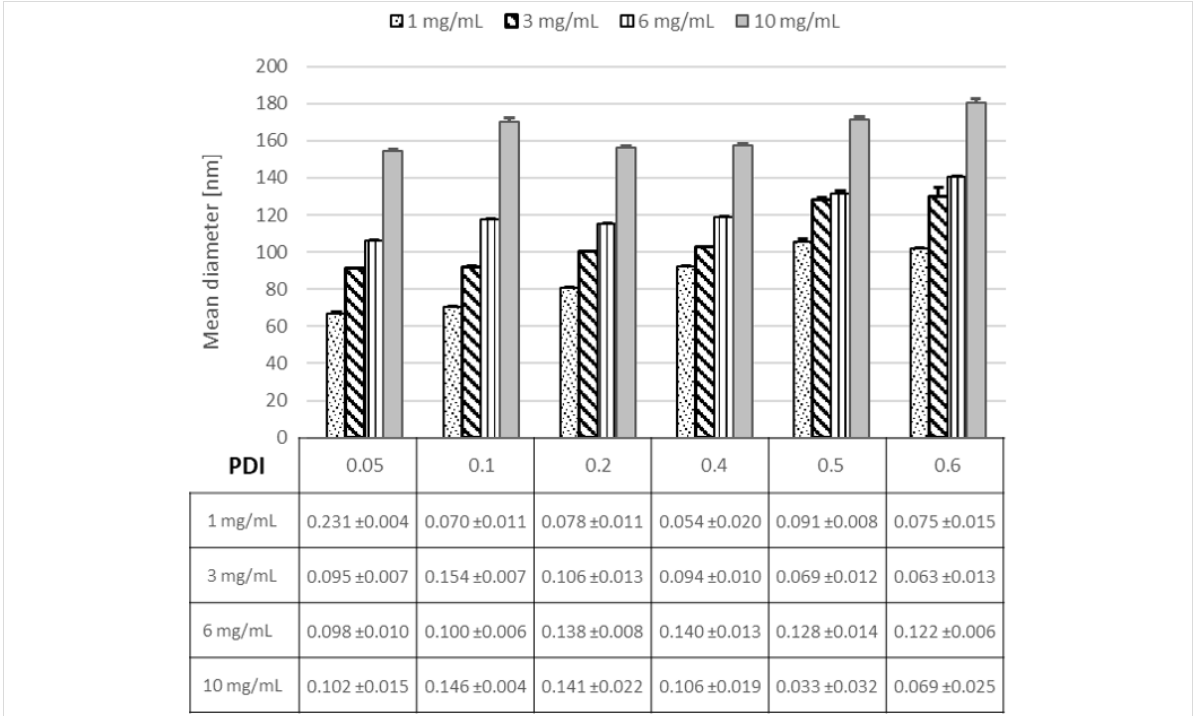
Figure 3: Effect of different PLGA concentrations (1–10 mg/mL) on NP size and PDI at different flow rate ratios.